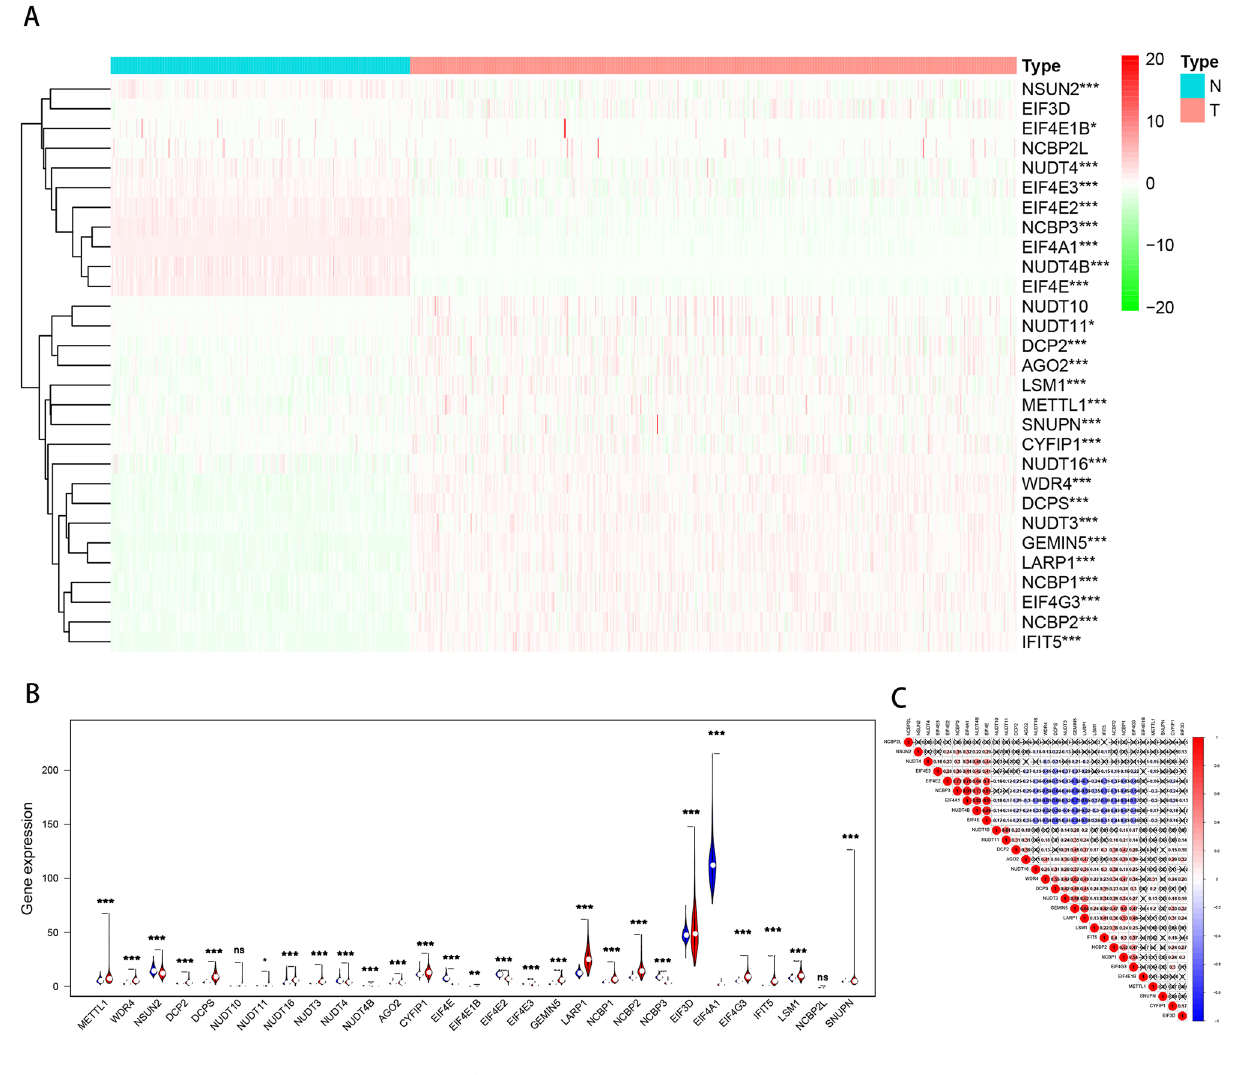
tissues (upregulated are marked in red, downregulated are marked in green; * P < 0.05, * P < 0.01, and *** P < 0.001). ( B ) Vioplot visualization of m 7 G RNA methylation regulators in melanoma (red is melanoma, blue is normal tissue). ( C ) Spearman correlation analysis of 29 m 7 GMRRGs in melanoma. m 7 G MRRGs N7-methylguanosine methylation-related regulator